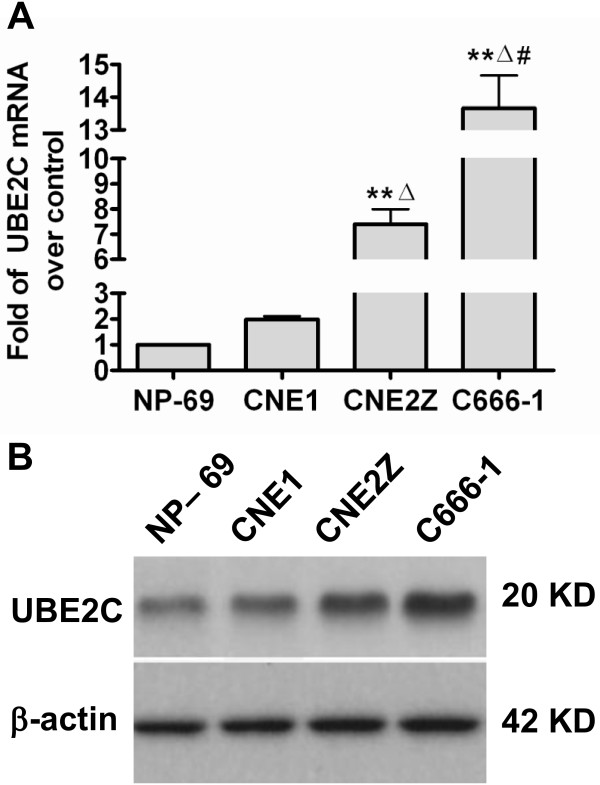
UBE2C expression in variously differentiated NPC cell lines and NP-69 cells. (A) Well-differentiated CNE1 cells, poorly-differentiated CNE2Z cells, undifferentiated C666-1 cells and immortalized NP-69 cells were seeded in triplicate in 24-well plates for each cell line (n=3), and were harvested for the analysis of UBE2C mRNA expression by qRT-PCR; β-actin was used as a loading control. **P<0.01 vs. NP-69, #P<0.05 vs. CNE1, ΔP<0.05 vs. CNE2Z. (B) Western blotting analysis the UBE2C protein expression in CNE1, CNE2Z, C666-1 and NP-69 cells. β-actin was used as a loading control.